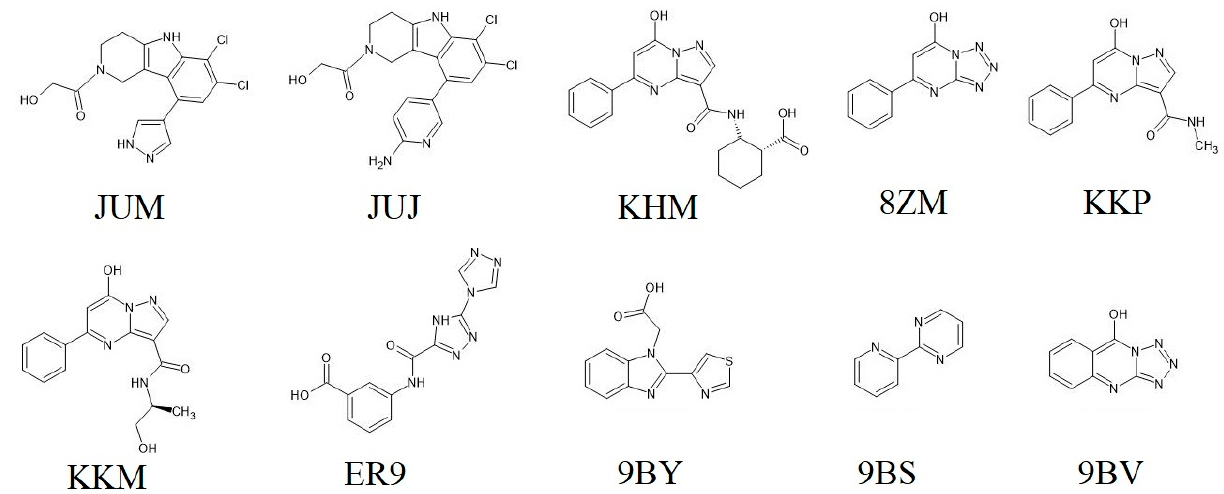
Figure 1. Chemical structures of the hcGAS-binding inhibitors used in this study with their protein data bank (PDB) names. Tricyclic pyridoindole core for JUM (pyrazole ring) and JUJ (2-amino pyridine ring), diazolo-pyrimidine aromatic core for KHM, KKP, and KKM, tetrazolo-pyrimidine aromatic core for 8ZM and 9BV (thiazole ring), bi (1, 2, 4-triazole) core for ER9, tricyclic benzimidazole core for 9BY, and pyridine and pyrimidine rings for 9BS are shown.